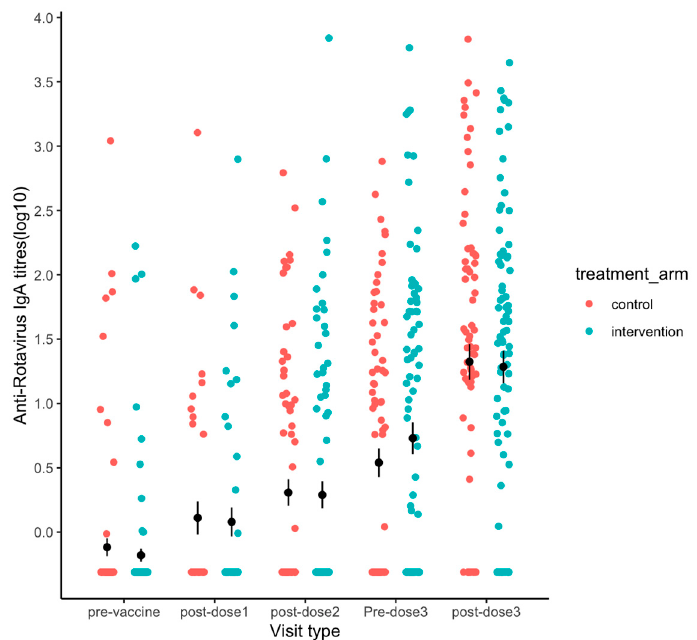
Figure 2. Trends in rotavirus-specific immunoglobulin A (RV-IgA) titres pre and post rotavirus vaccination compared between the control (red circle) and intervention (blue circle) arms. Each circle represents an infant’s log10 RV-IgA titre. Black circle represents mean and standard error of log RV-IgA titre.